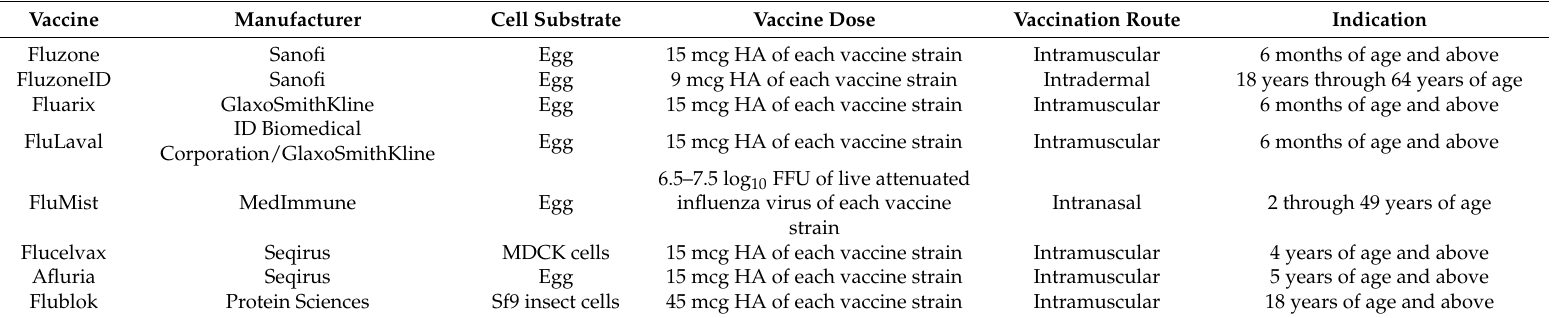
Table 1. Quadrivalent Influenza Vaccine (QIV) licensed in the United States.